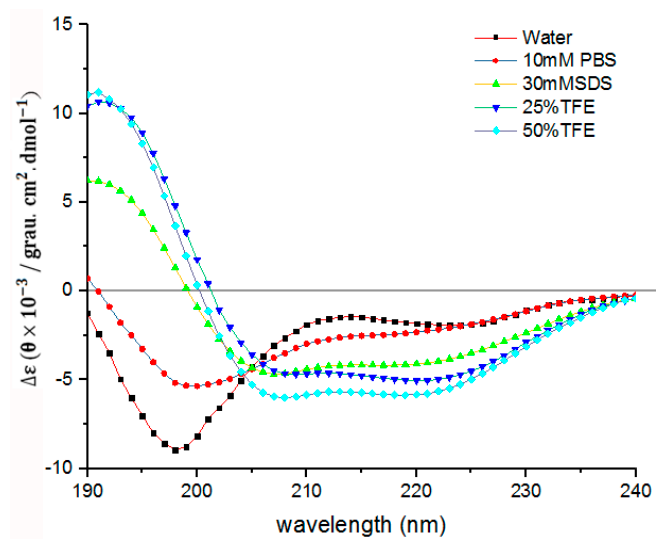
Figure 11. Circular dichroism spectra of LGH2. The peptides were dissolved in water, 10 mM sodium phosphate buffer (pH 7.4), 30 mM SDS, 25% TFE, and 50% TFE, respectively, to make the final concentration of the peptide 100 μ M. The values from these three scans were averaged per sample. Table 3. Percentage of secondary structures according to the deconvolution of CD spectra of LGH2